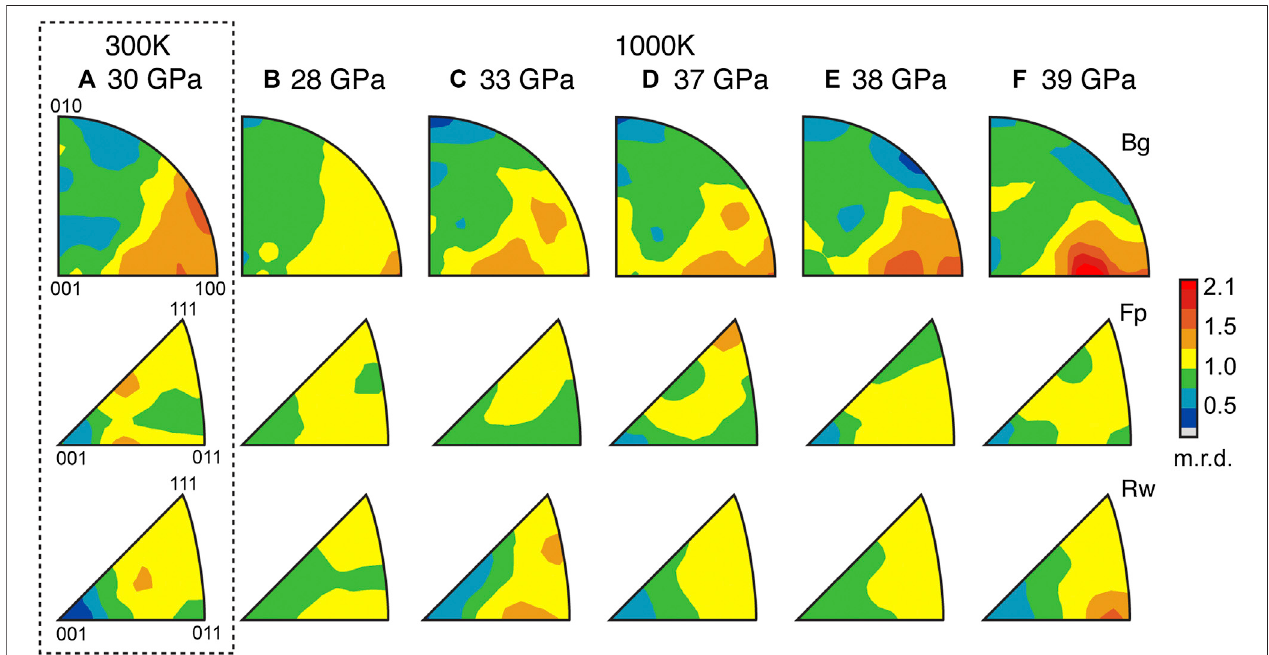
FIGURE3| InversePole fi gures(compressiondirection)ofabridgmanite(Bg),ferropericlase(Fp),andringwoodite(Rw)aggregatecompressednon-hydrostatically at a constant temperature of ∼ 1,000 K. The post-conversion texture is shown for reference in (A) at 30 GPa and 300 K and is separated from the resistive heating textures by a black, dashed, and rectangular contour. The onset of simultaneous heating and compression occurs at (B) ∼ 28 GPa, and the experiment ends at (F) ∼ 39.0 GPa. Pressures are calculated from the cell parameter ofPt ( Table 1 ). Associated diffraction images are (A) 001, (B) 139, (C) 145, (D) 160, (E) 166, and (F) 172. The scale bar shows multiples of random distribution